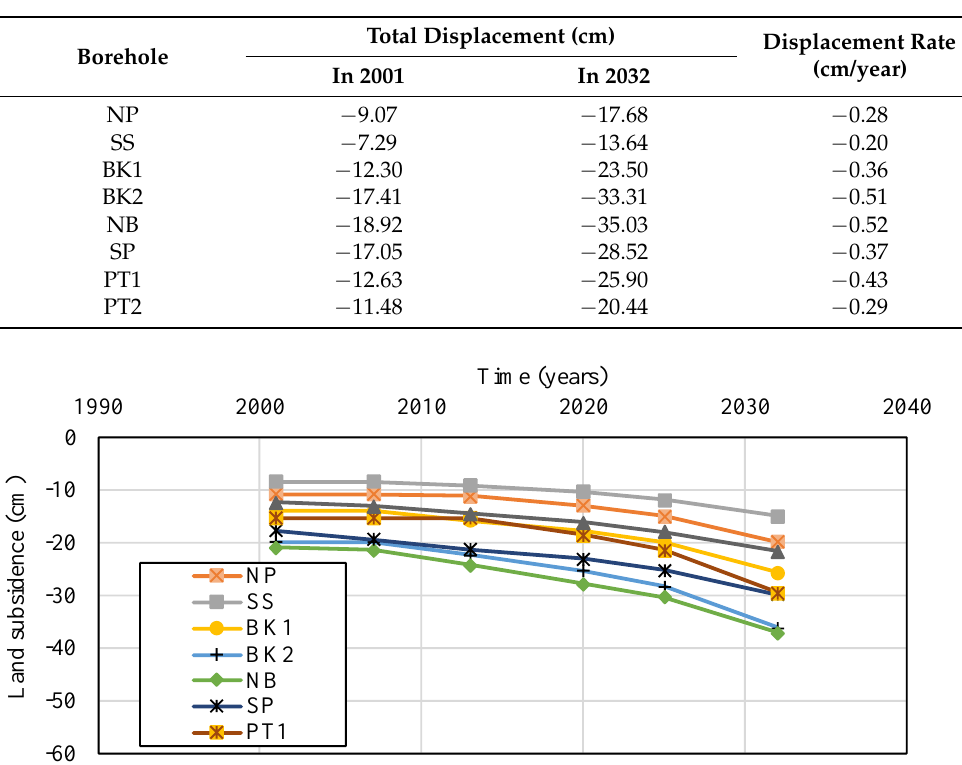
Figure 9. Comparison of the evaluation of soil surface displacement in various studies. [Modified Ref [11,18,19]